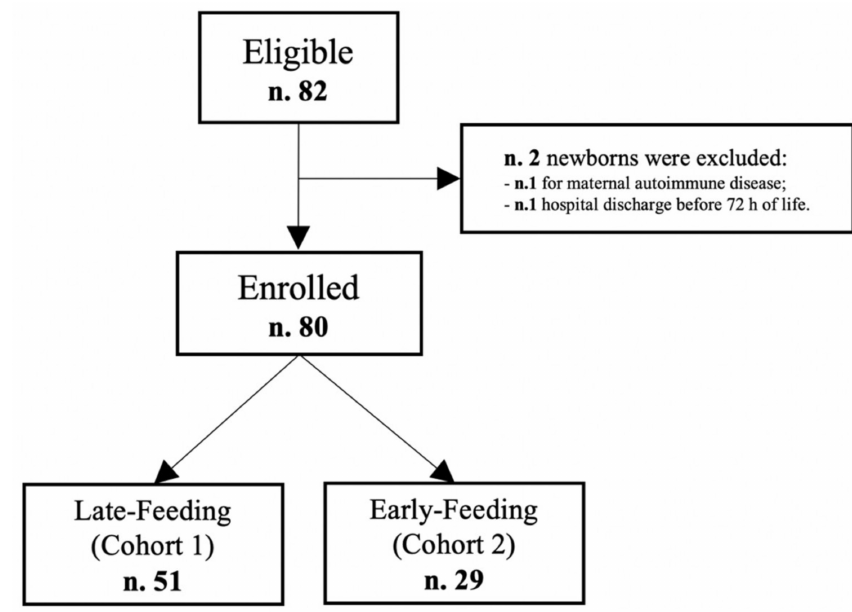
Figure 1. Flowchart of the study sample.